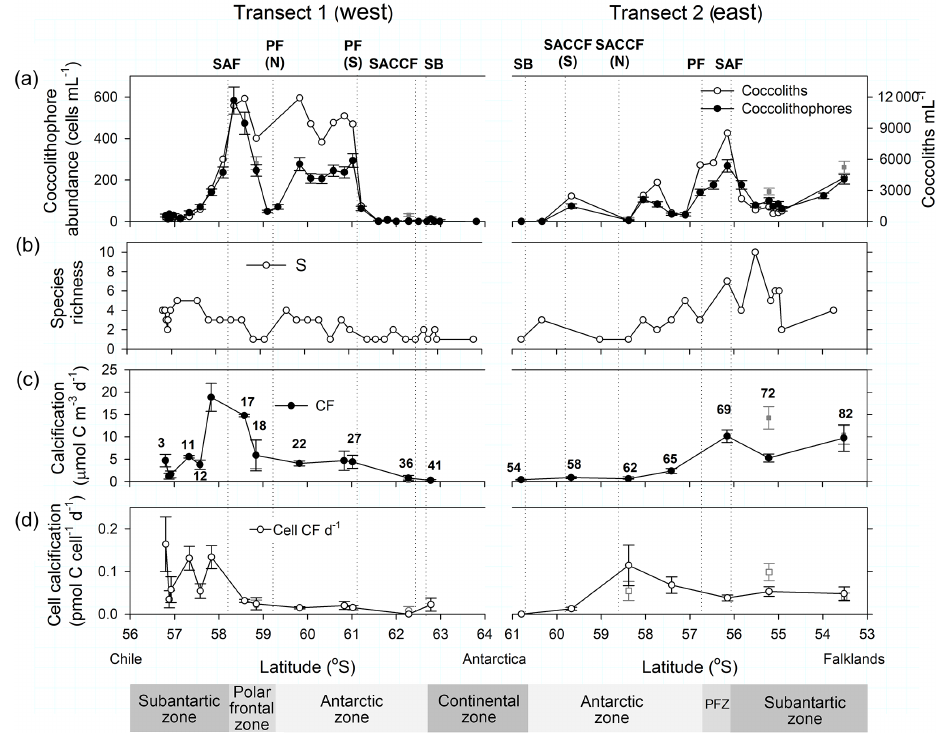
Figure 5. Surface water (5m) distribution of coccolithophore variables along Transect 1 (left) and Transect 2 (right). (a) Total coccolithophore and detached coccolith abundance. (b) Species richness. (c) Community (bulk) calcification rates. (d) Cell-specific calcification rates. Grey filled and open squares show coccolithophore abundance, calcification and cell-specific calcification at 50m depth, if the maximum was observed at this